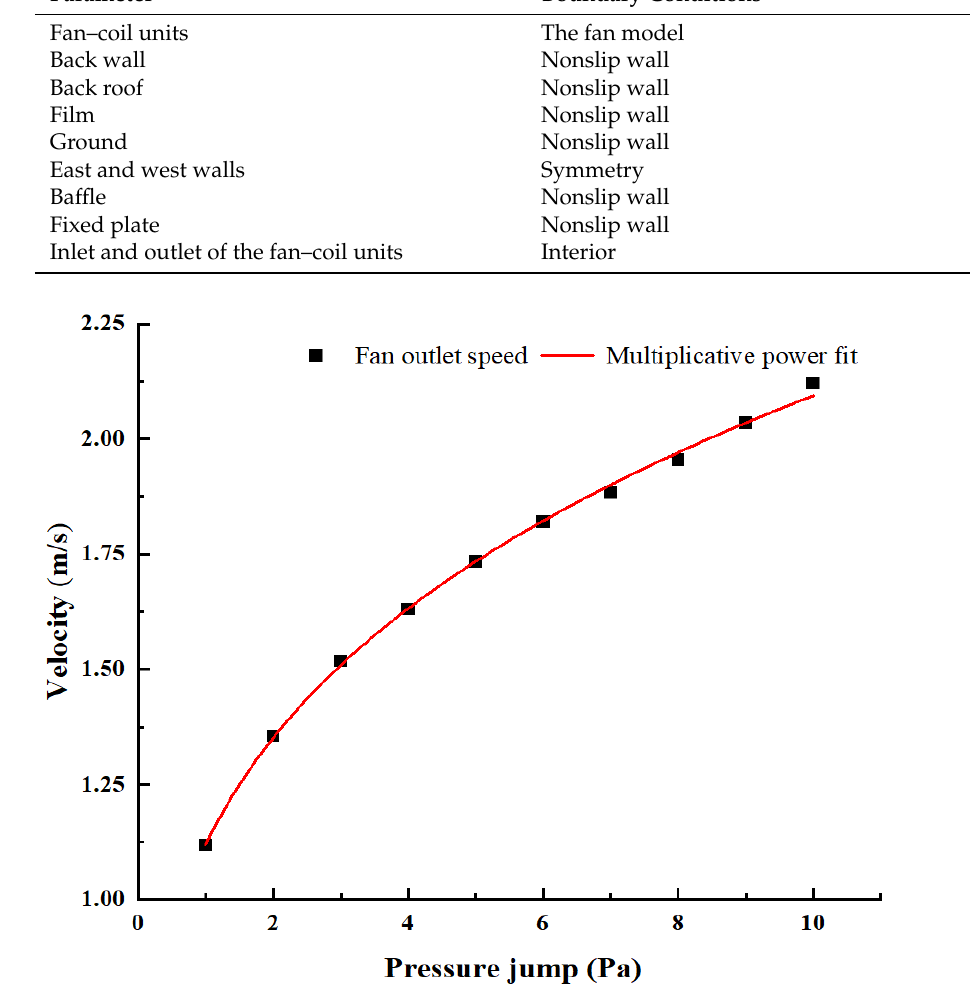
Figure 5. Diagram of pressure jump versus fan outlet velocity.